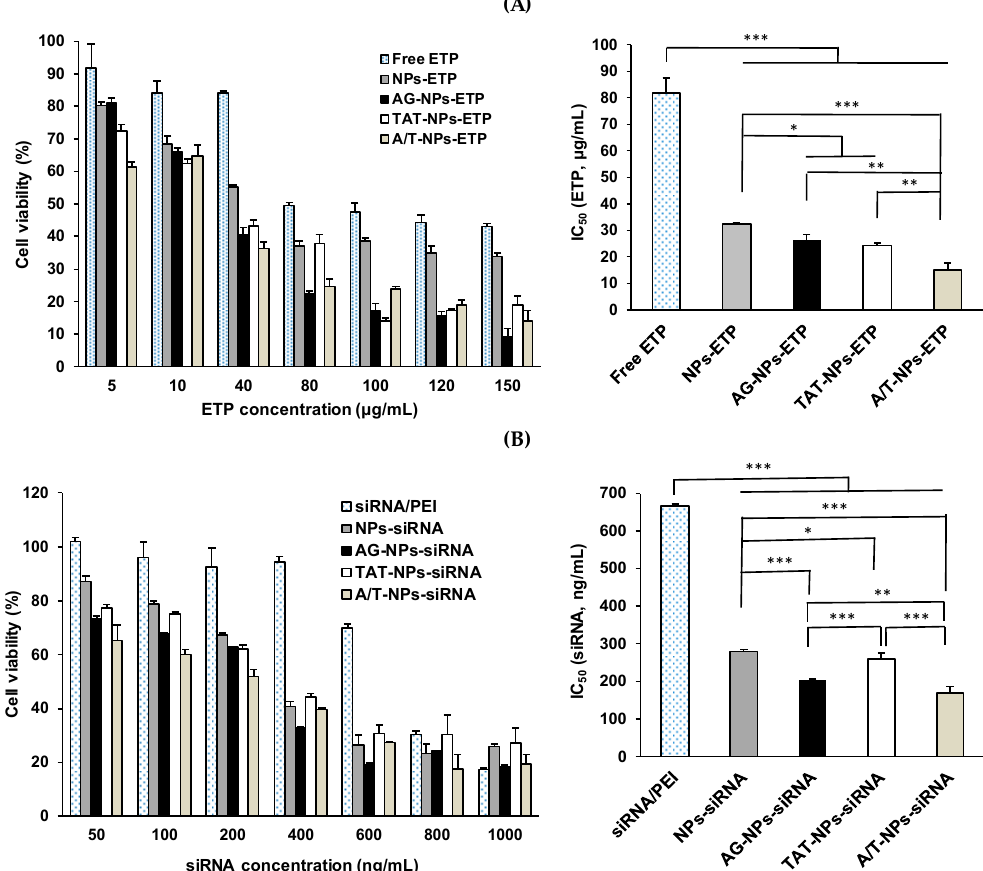
Figure 7. Cytotoxicity in CD133(+) H69 cells after treated by peptide-free, single-peptide and dual-peptide modified ( A ) ETP@NPs and ( B ) siRNA@NPs for 72h and their corresponding IC 50 . (* p < 0.05, ** p < 0.01, *** p < 0.001, n = 3).